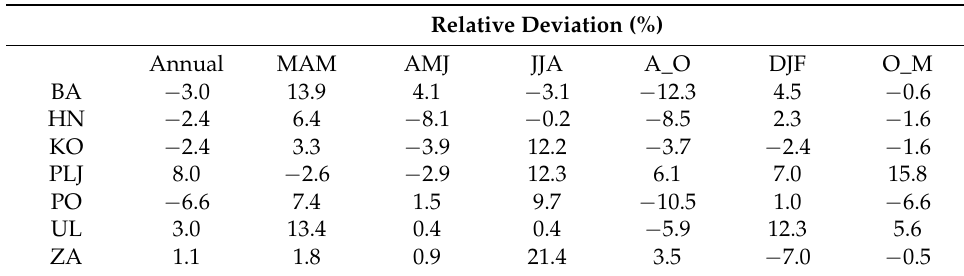
Table 3. The relative deviation (%) of the average annual precipitation for 2001–2030 climate in respect